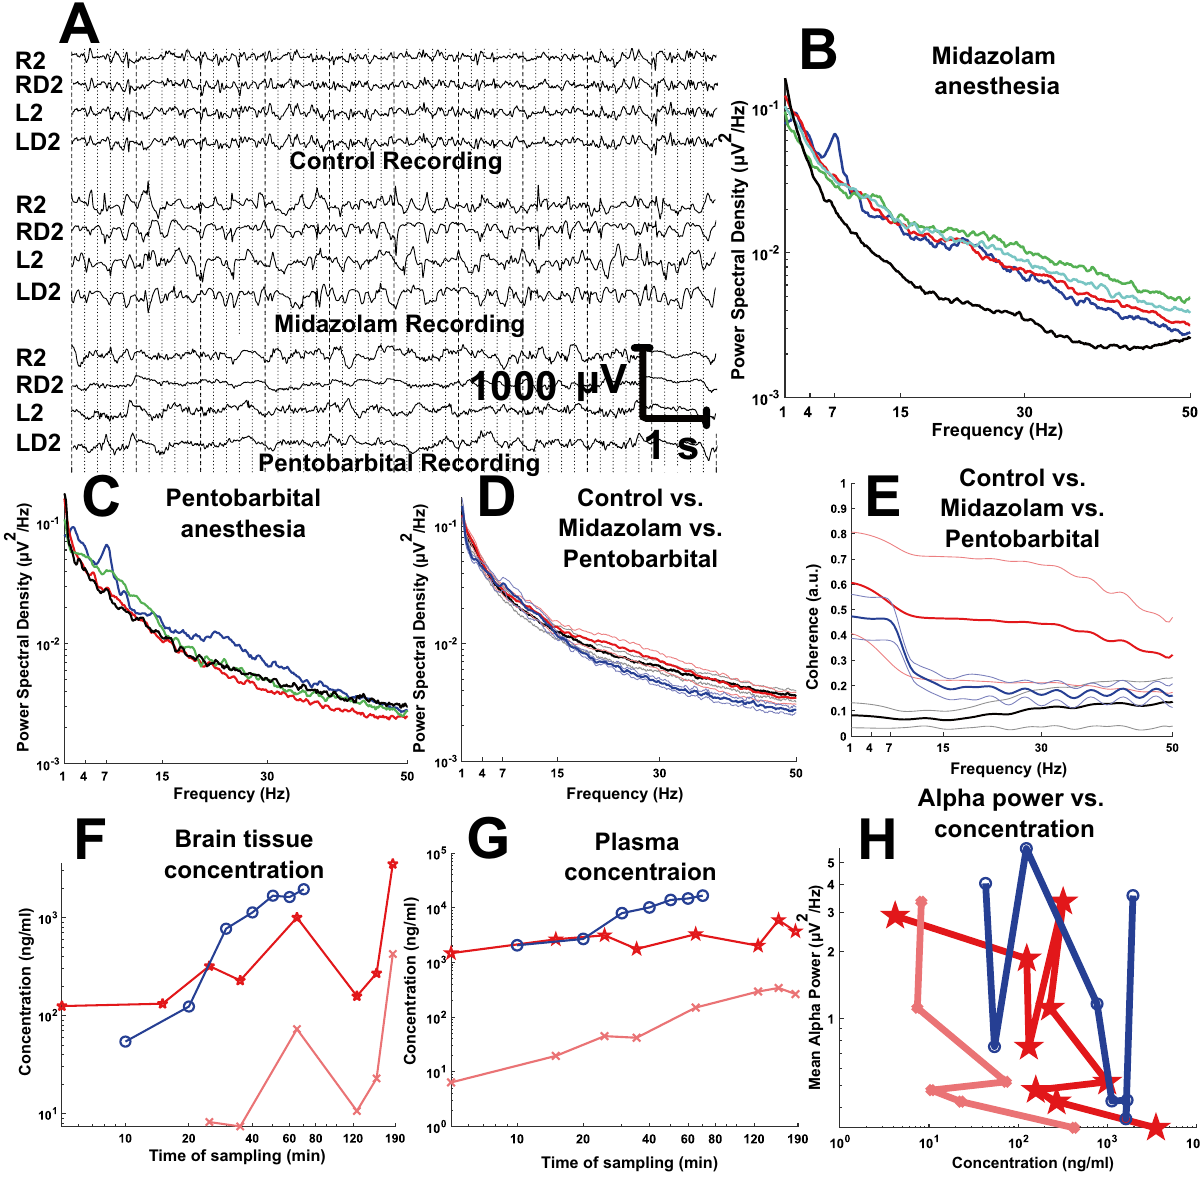
Figure 5. Neurophysiological effects of intravenous anesthetics. Midazolam, Pentobarbital and Isoflurane (control) anesthesia ECoG. ( A ) ECoG traces of control, midazolam and pentobarbital anesthesia. ( B ) Power spectra of control (blue line), 0.5 mg/Kg/h (red line), 1 mg/Kg/h (green line), 2 mg/Kg/h (cyan line), 3 mg/Kg/h (black line) Midazolam IV infusion. ( C ) Power spectral of control (blue line), 20 mg/kg/h (red line), 40 mg/ kg/h (green line), 60 mg/kg/h (black line) Pentobarbital IV infusion. ( D ) Mean and standard error of control (black line), midazolam (red line), and pentobarbital (blue line) power spectra. ( E ) Mean and standard error of control (black line), midazolam (red line), and pentobarbital (blue line) coherence spectra. ( F ) Brain tissue mean concentration relative to time of sampling of pentobarbital (o labels and blue line), hydroxy- (OH)-midazolam (x labels and light red line), midazolam (pentagrams and red line). in infused subjects. ( G ) Plasma mean concentration versus time of plasma sampling of pentobarbital (o labels and blue line), OH-midazolam (x labels and light red line), midazolam (pentagrams and red line). ( H ) Mean alpha power comparison with the increase in brain mean tissue concentration of pentobarbital (o labels and blue line), OH-midazolam (x labels and light red line), midazolam (pentagrams and red